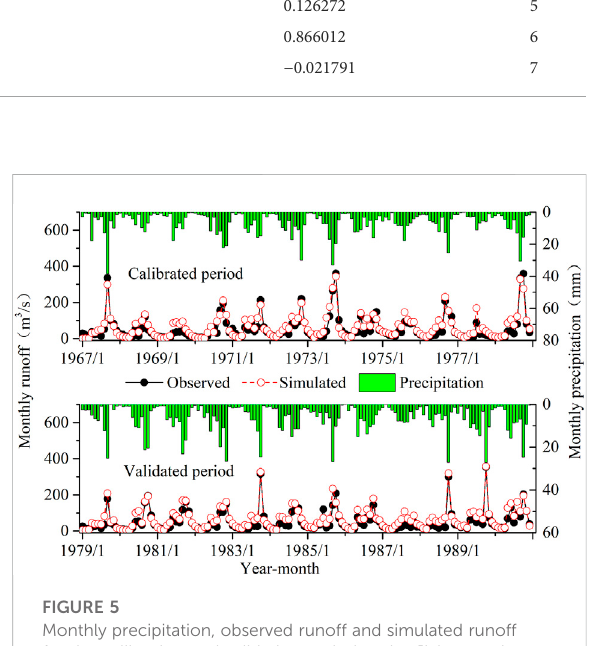
FIGURE 5 Monthly precipitation, observed runoff and simulated runoff for the calibration and validation period at the Jiabao